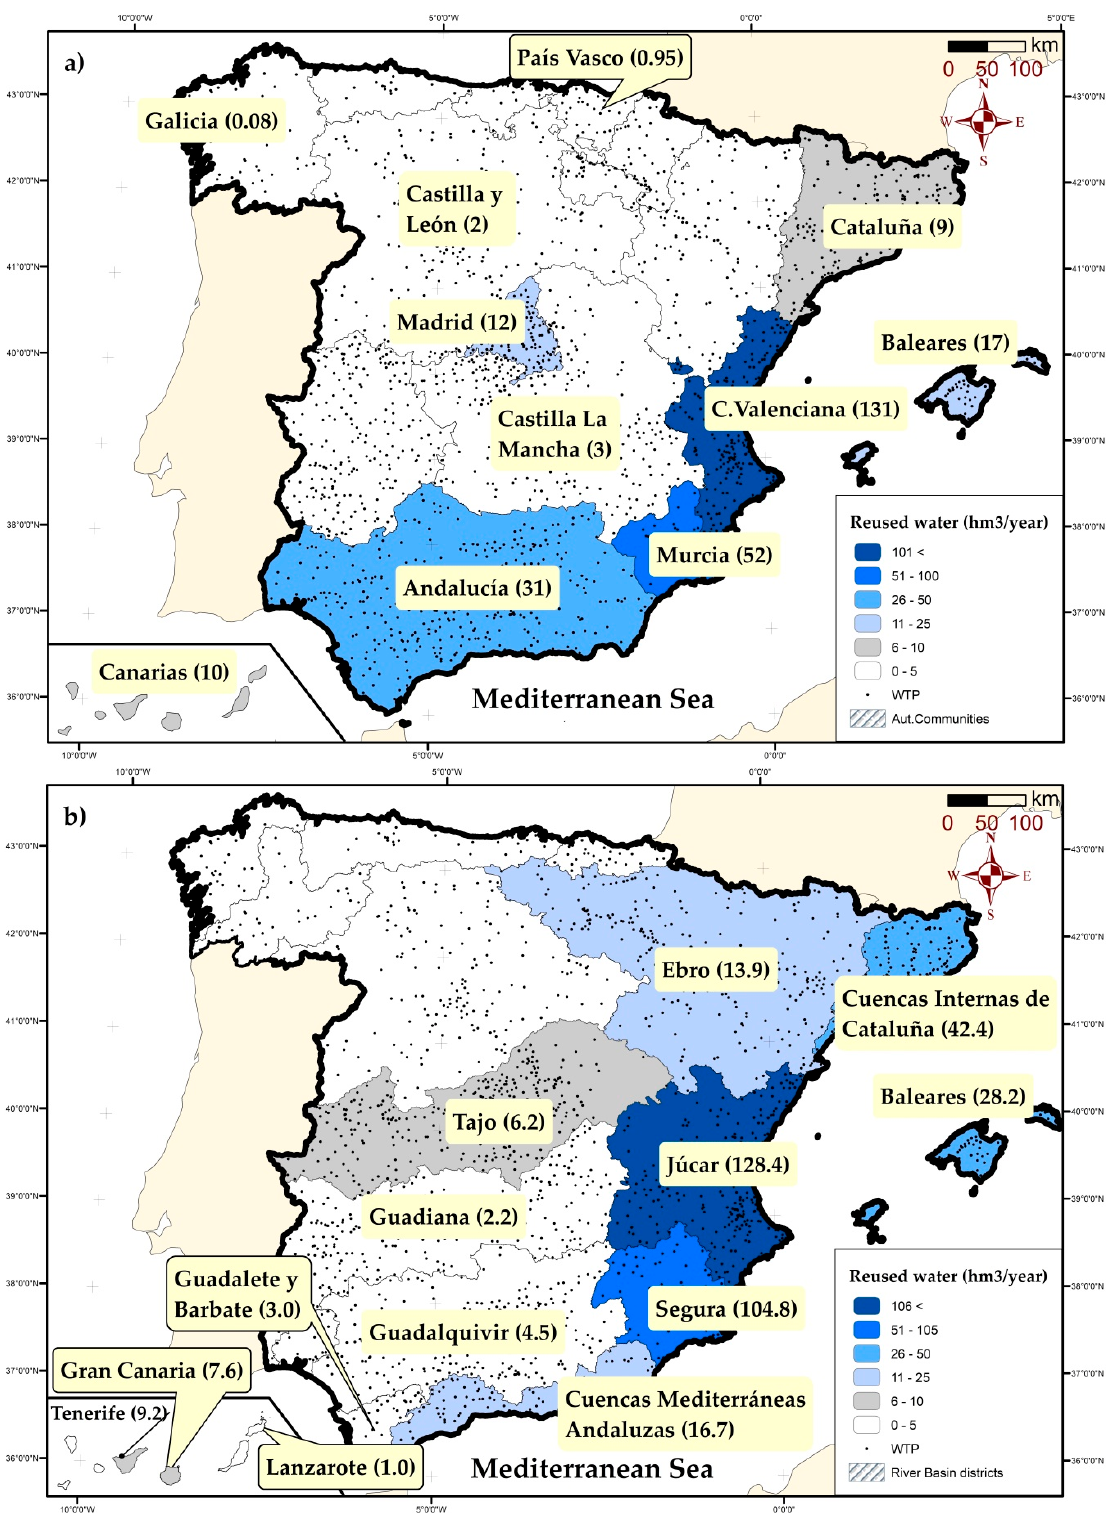
Figure 3. ( a ) Wastewater reused in the Spanish Autonomous Communities (hm 3 / year) in 2016; ( b ) Wastewater reused in the Spanish River Basin districts (hm 3 / year) in 2010. Both of them ( a , b ) depict the location of wastewater plants (reference year: 2015). Source: own elaboration based on [41,42,45,74,75].